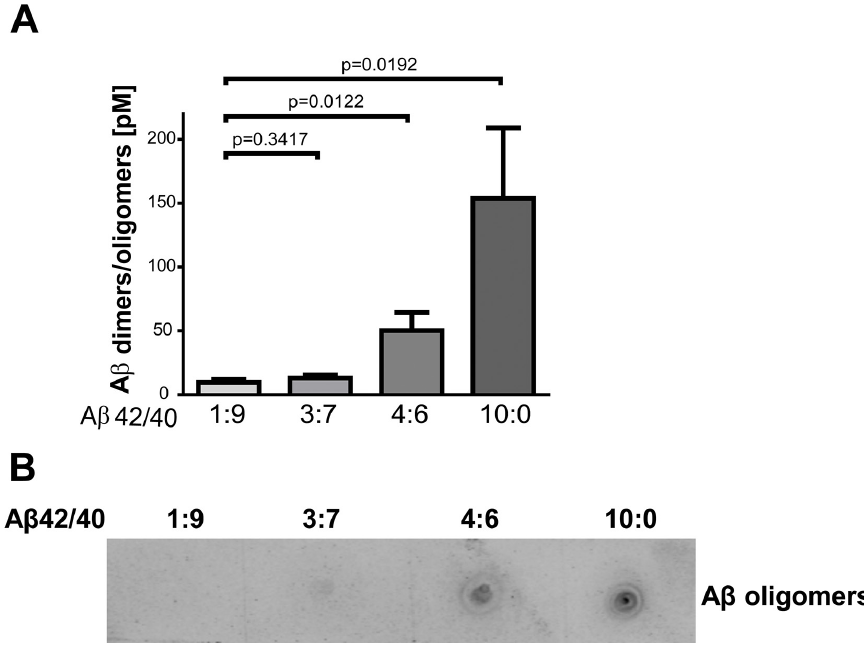
Figure 1. Characterization of A β peptides. (A) ELISA analysis of the A β dimers/oligomers in the mixtures of the A β 42 and A β 40 peptides mixed at the ratios of 1:9, 3:7, 4:6 and 10:0 at the total 1 μ mol/L A β concentration. n = 9, mean ± SEM, two-tailed unpaired Student t test. (B) The representative dot blot presents the abundance of A β oligomers detected by A β oligomer specific antibody in the mixtures of the A β 42 and A β 40 peptides mixed at the ratios of 1:9, 3:7, 4:6 and 10:0 at the total 1 μ mol/L A β concentration. A β – amyloid β